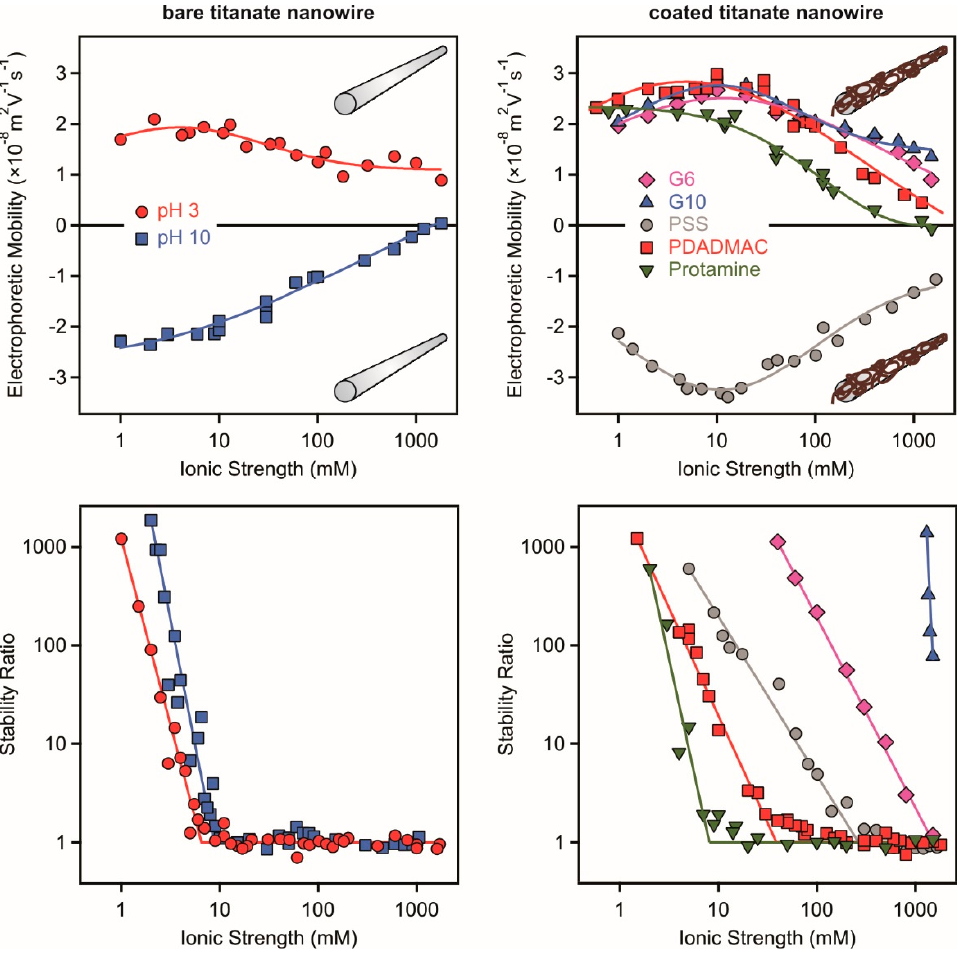
Figure 7. Charging and aggregation of bare ( left column ) and polyelectrolyte-coated (PAMAM dendrimers of generation 6 and 10, PSS, PDADMAC and protamine, right column ) titanate nanowires. Electrophoretic mobilities ( top row ) and stability ratios ( bottom row ) as a function of the ionic strength adjusted by KCl. In the nanowire-PSS system pH 3 was set, while in the others pH 9, corresponding to positively and negatively charged particles, respectively. The data were taken from references [62,63,66,92].